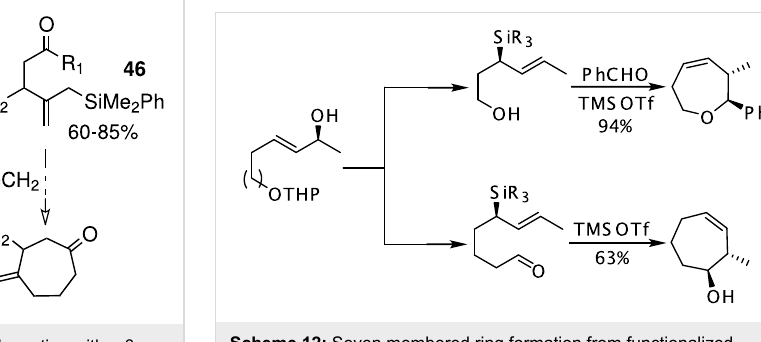
Scheme 10: Silylcupration of 1,2-propadiene and reaction with α,β- unsaturated nitriles.